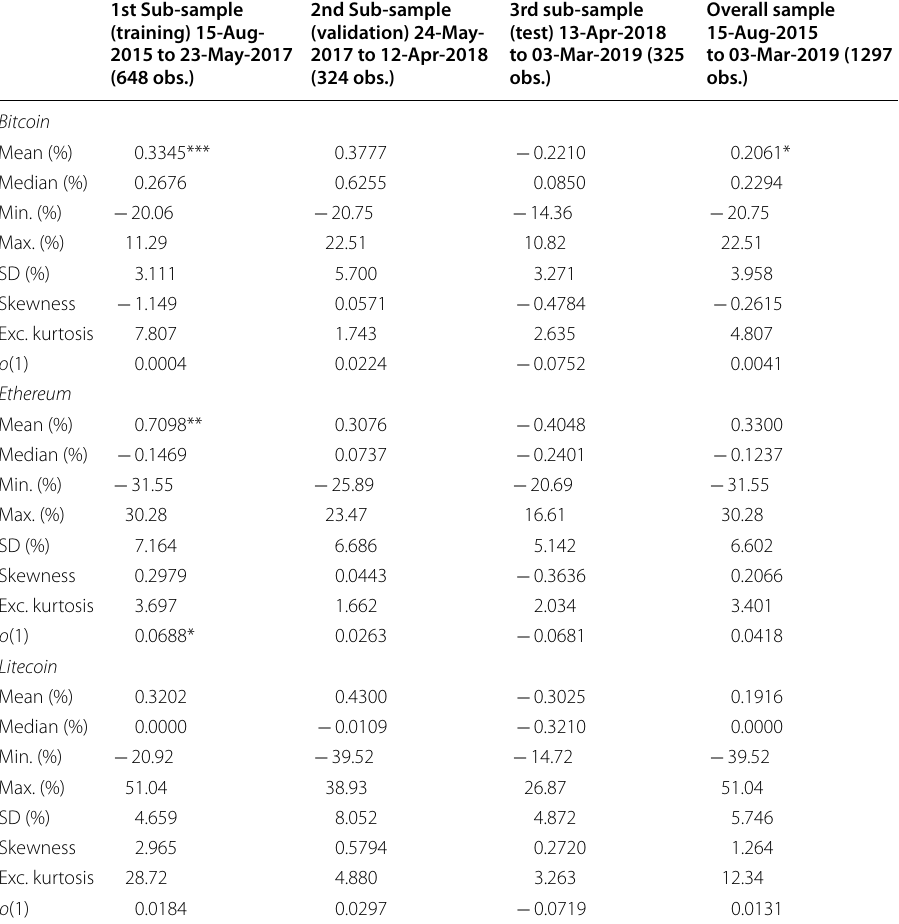
Table 3 Summary statistics on the returns of bitcoin, ethereum and